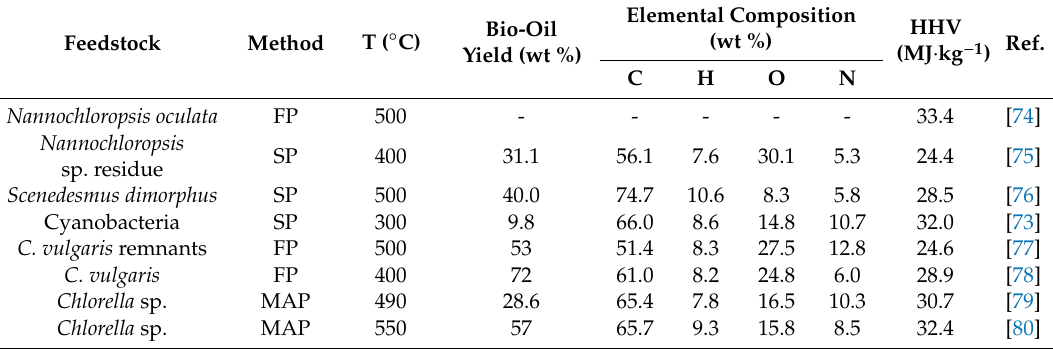
Table 1. Properties of bio-oil from non-catalytic